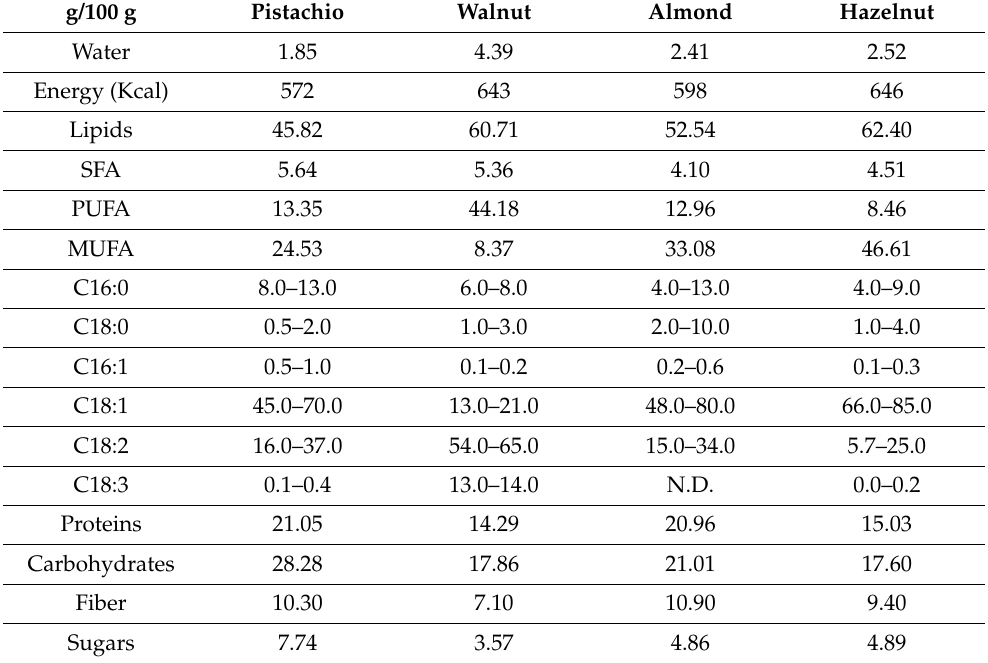
Table 1. Composition (g/100 g) in nutrients of dry roasted nuts. Source: USDA National Nutrient Database for Standard Reference (2020). MUFA: monousaturated fatty acids; SFA: saturated fatty acids; PUFA: polyunsaturated fatty acids. g/100 g Pistachio Walnut Almond Hazelnut